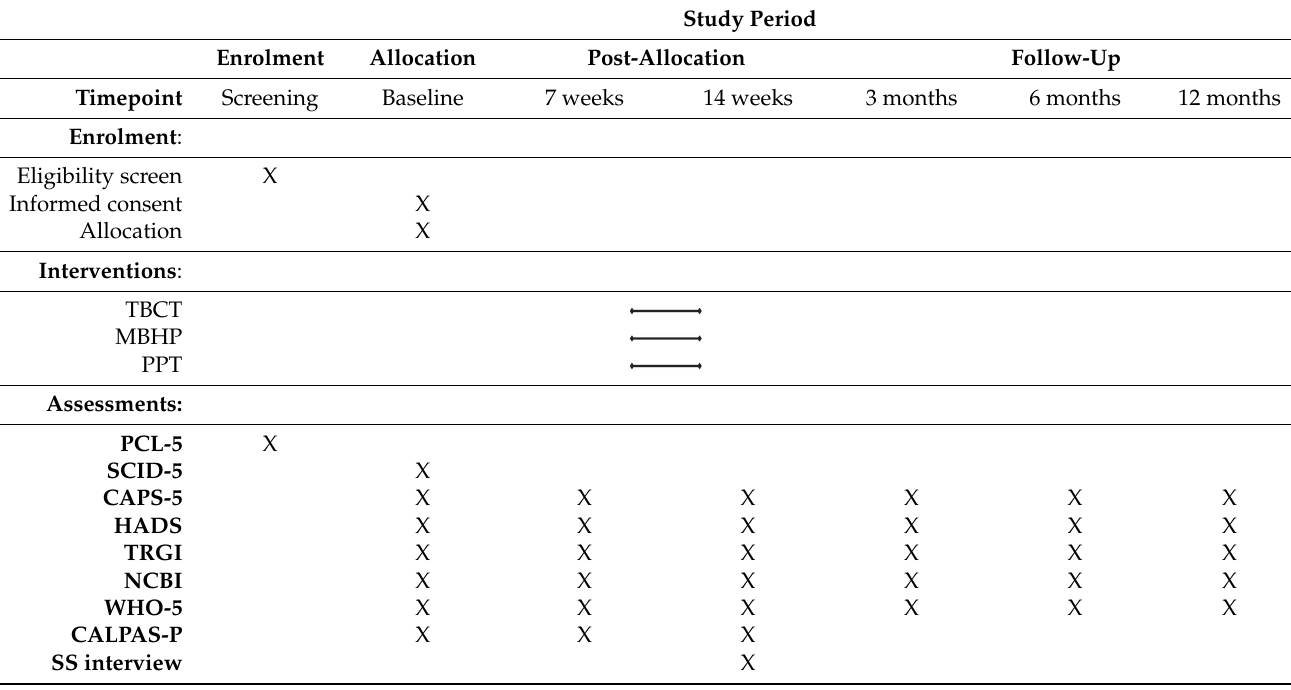
Table 1. Flow of sessions and evaluations over the study period. Study